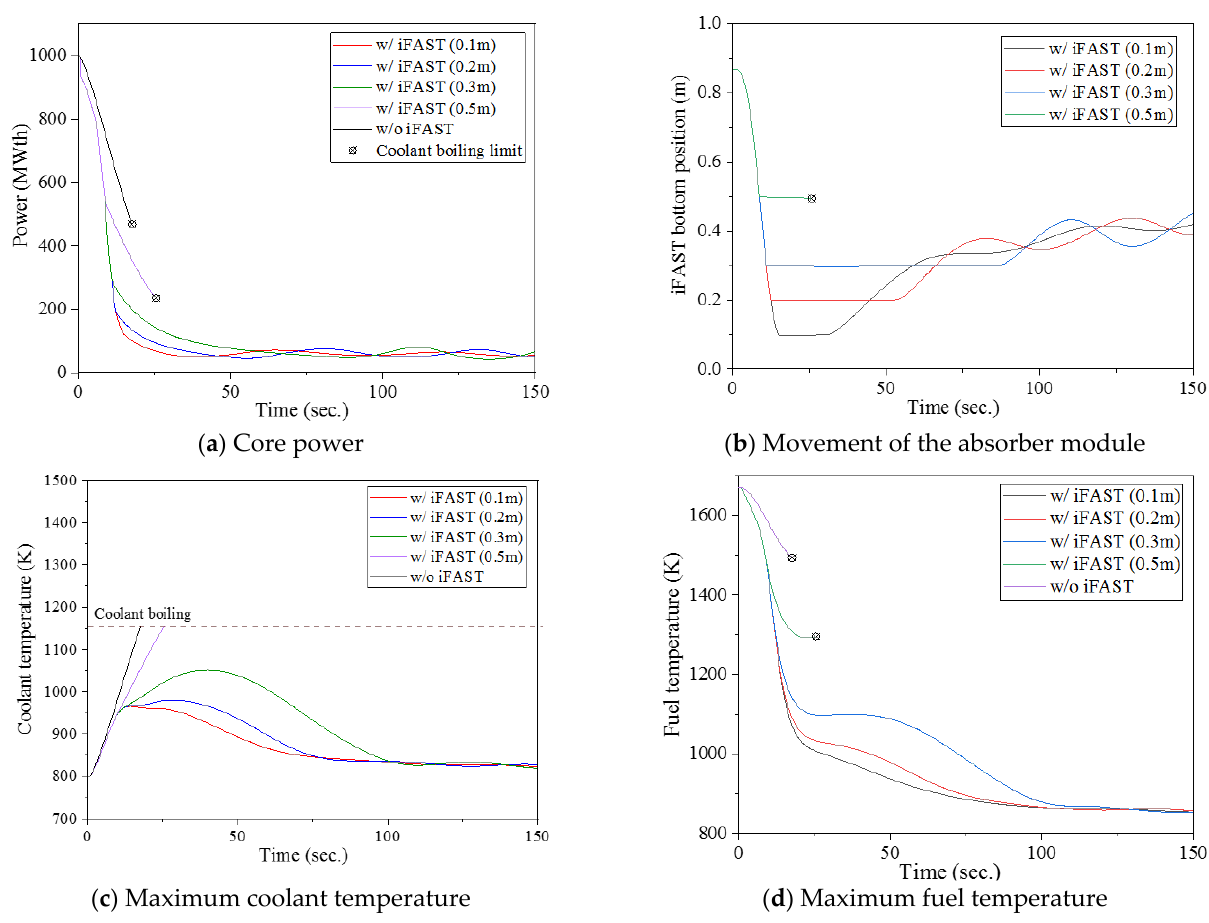
Figure 5. Unprotected loss of flow in ABR reactor and 1.8$ maximum iFAST worth.